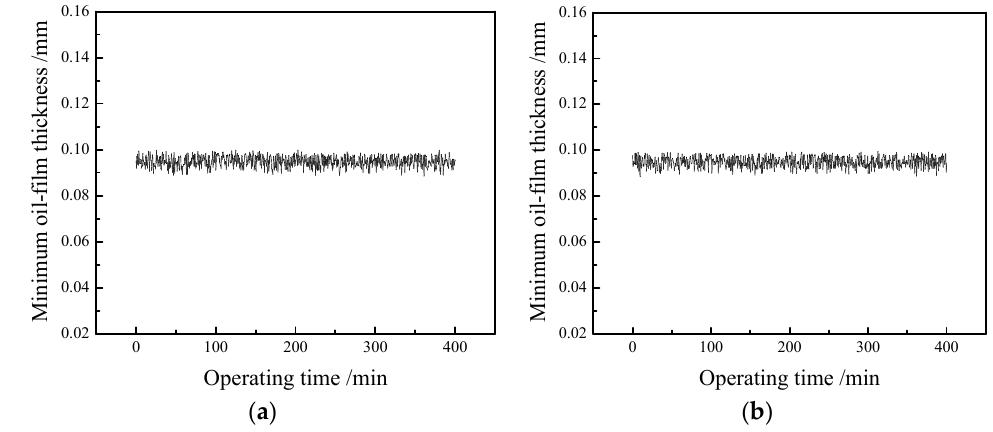
Figure 14. The comparison of minimum oil ‐ film thickness between S220 and M220 at 150 rpm ‐ 6 MPa. ( a ) S220; ( b ) M220.